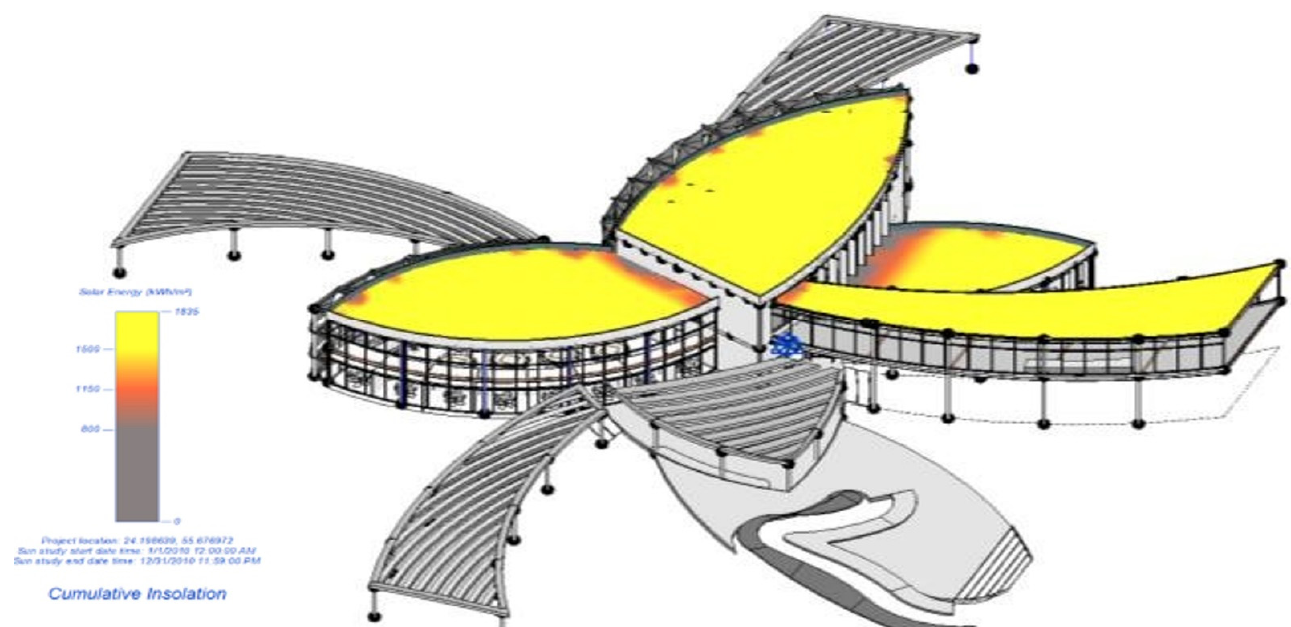
Figure 24. Energy models: ( a ) south view before parametric façade; ( b ) north-east view before parametric façade, ( c ) south view after parametric façade; ( d ) north-east view after parametric façade.